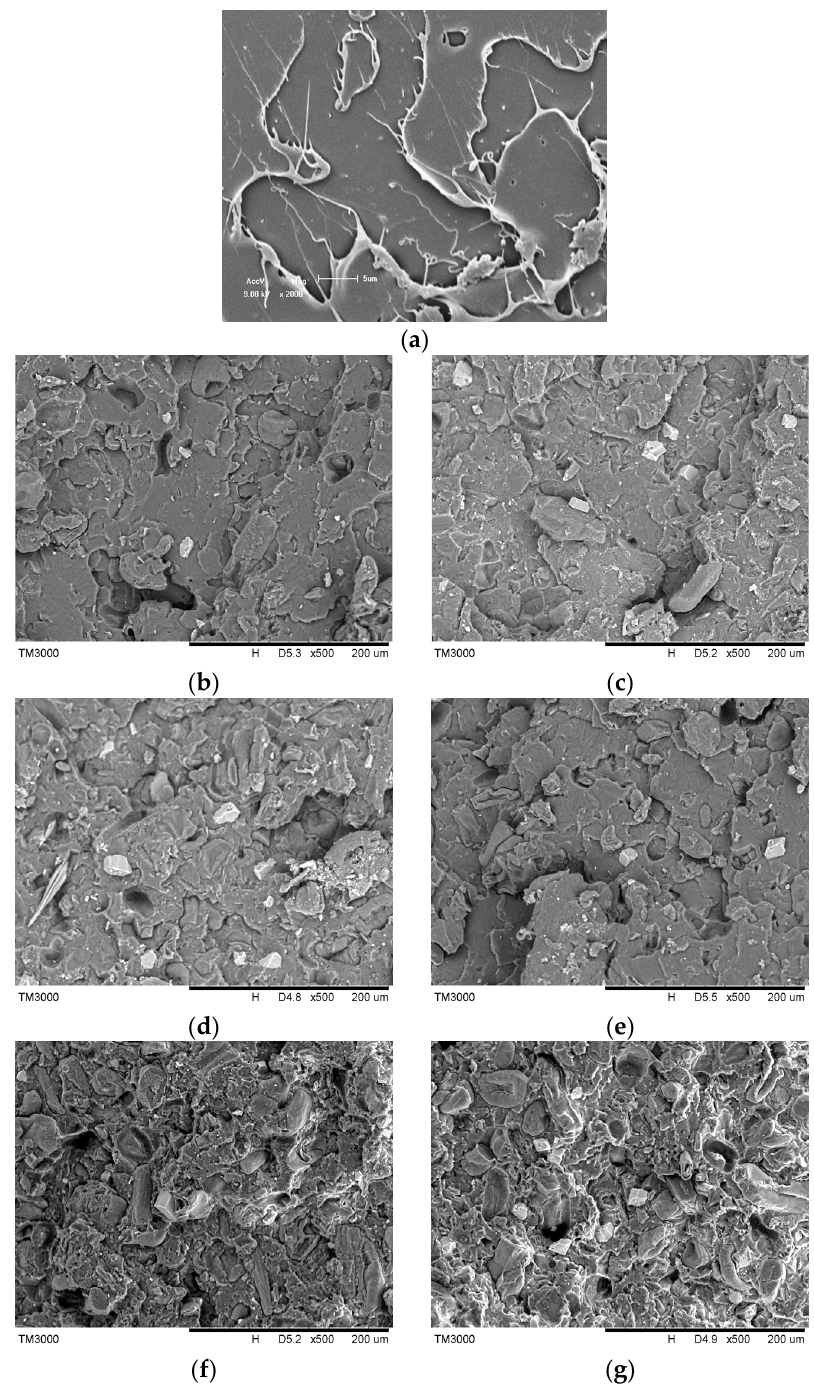
Figure 3. SEM micrographs of the fractured surfaces of the eco-composites. ( a ) neat PLA; ( b ) PLA/PF (90 wt %/10 wt %); ( c ) PLA/T-PF (90 wt %/10 wt %); ( d ) PLA/PF (70 wt %/30 wt %); ( e ) PLA/T-PF (70 wt %/30 wt %); ( f ) PLA/PBAT/T-PF (60 wt %/10 wt %/30 wt %); ( g ) PLA/PBAT/T-PF (50 wt %/20 wt %/30 wt %).